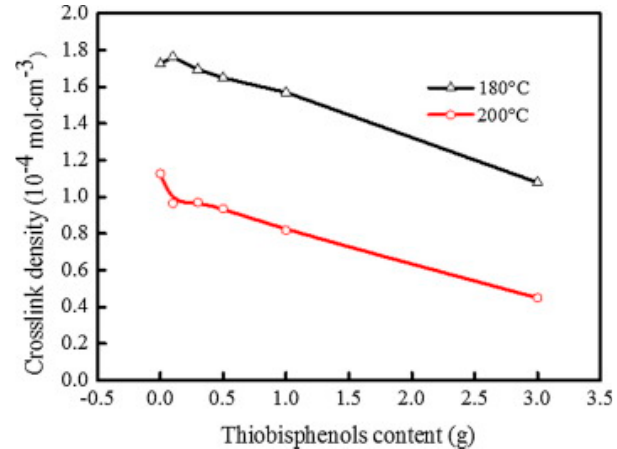
Figure 16. E ff ect of thiobisphenols content and temperature on the crosslink density of reclaimed rubber (reproduced with permission from [97]).